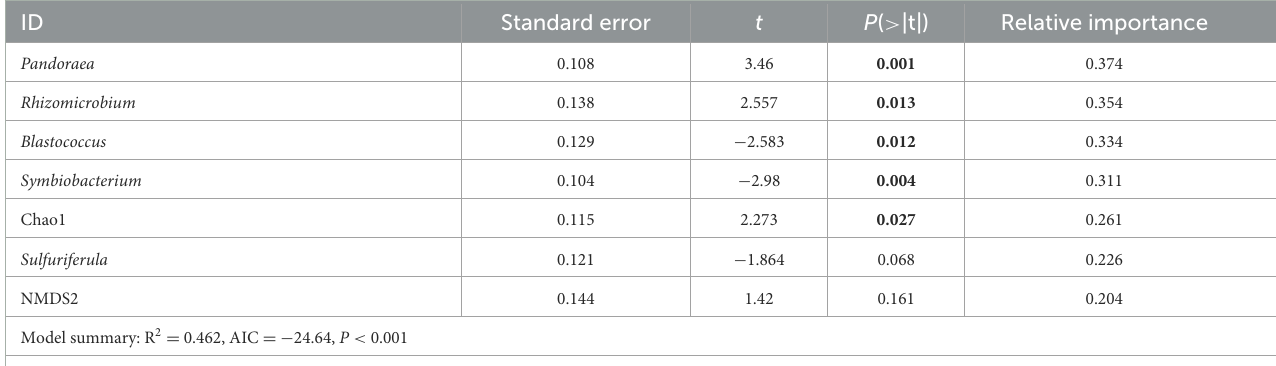
TABLE 1 Linear models (LM) for the relationship of bacterial indicators with American ginseng root rot disease and the relative importance of each of the predictors in the model.